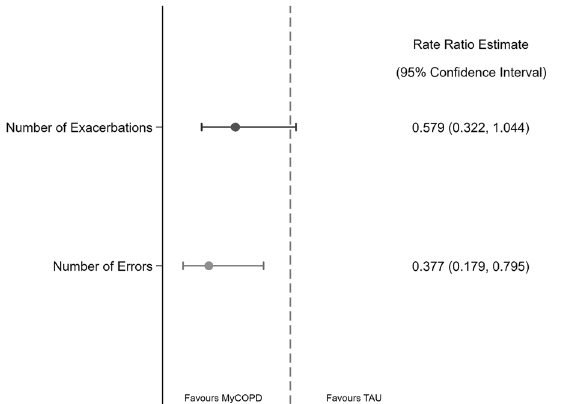
Fig. 4 Rate ratio estimates of numbers of exacerbations and inhaler errors. Indicated are the incidence rate ratio estimates (and 95% con fi dence intervals) for number of exacerbations and inhaler